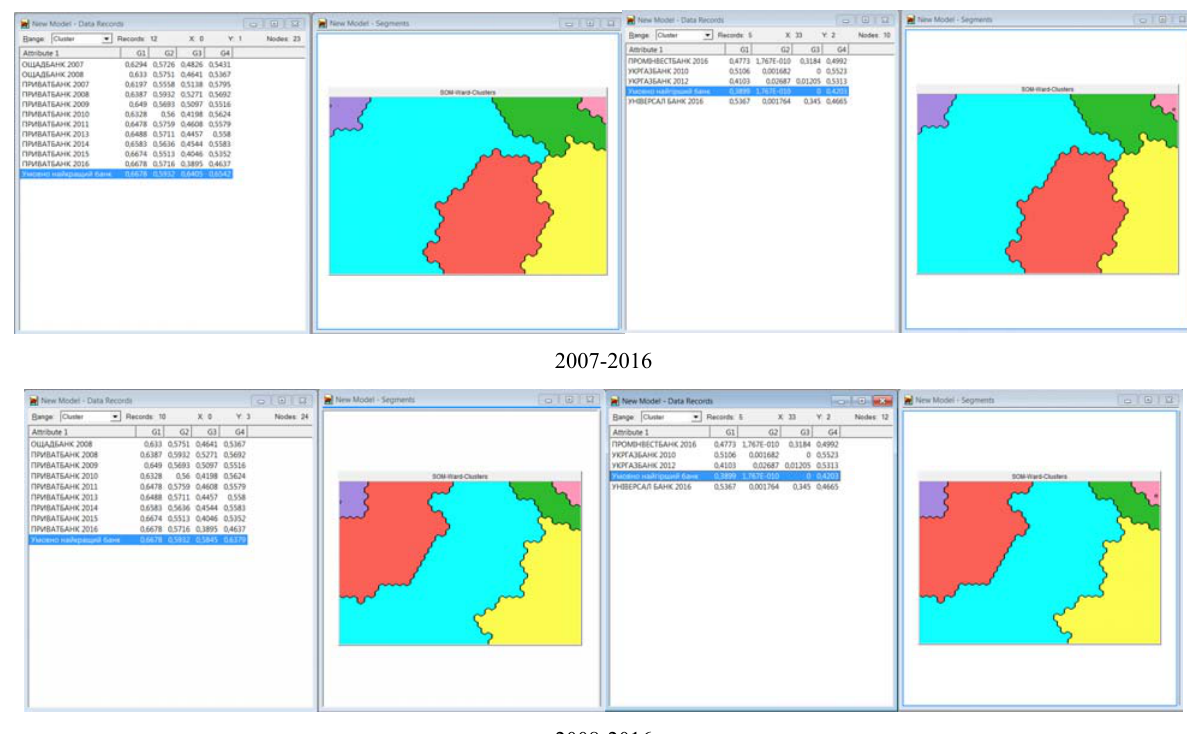
Fig. 2. Adequacy model